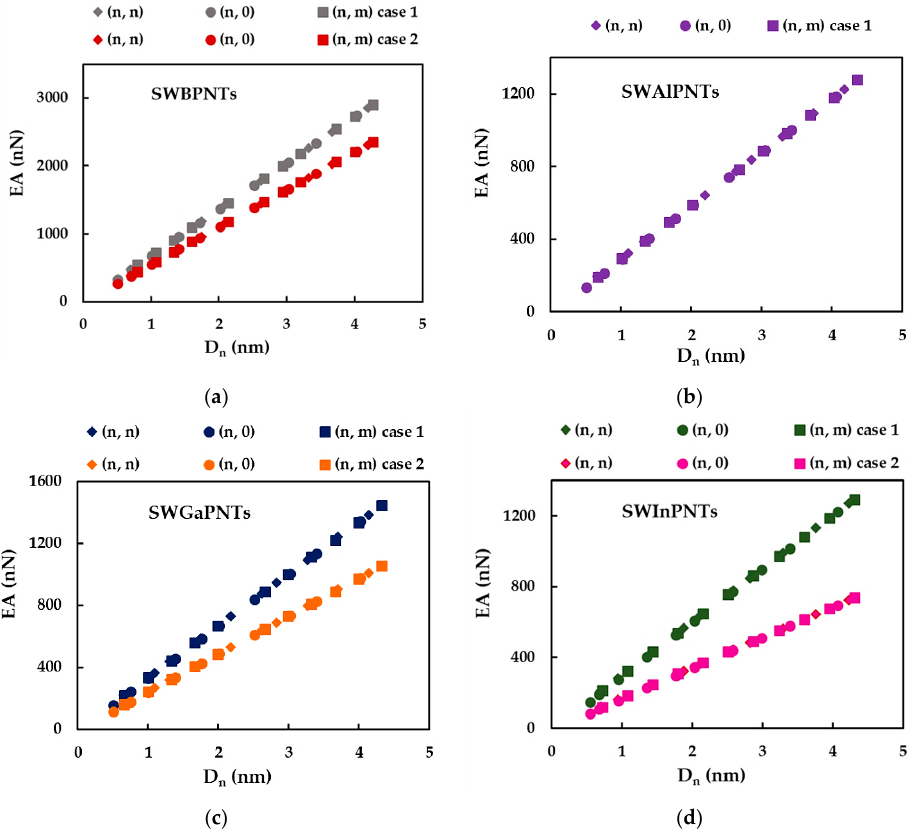
Figure 6. Evolution of tensile rigidity, EA, as a function of the nanotube diameter, D n , for: ( a ) SWBPNTs; ( b ) SWAlPNTs; ( c ) SWGaPNTs; and ( d ) SWInPNTs.